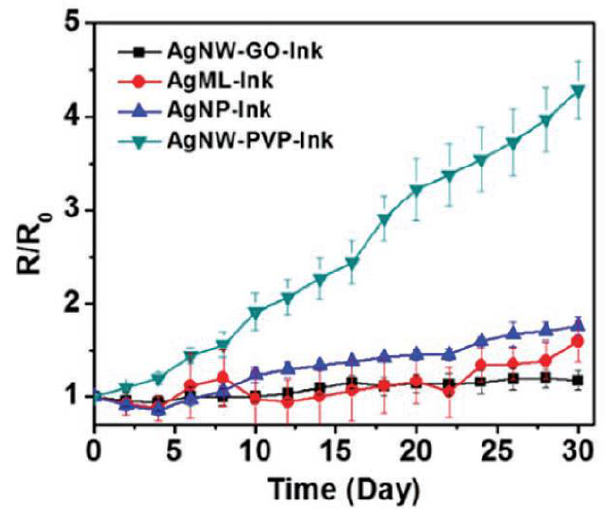
Figure 18. Plots of relative resistance change versus time for AgNW-GO-Ink, AgNW:PVP-Ink, AgNP-Ink, and AgMF-Ink electrodes drawn on paper substrates after exposure to hot air at 60 °C for 30 d. AgMF- silver microflakes; AgNP — silver nanoparticles, AgNW — silver nanowires. Reprinted with permission from [71]. Copyright 2017: Elsevier.